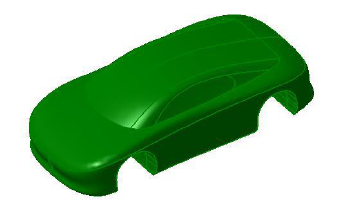
Figure 4. The sketch of a car.